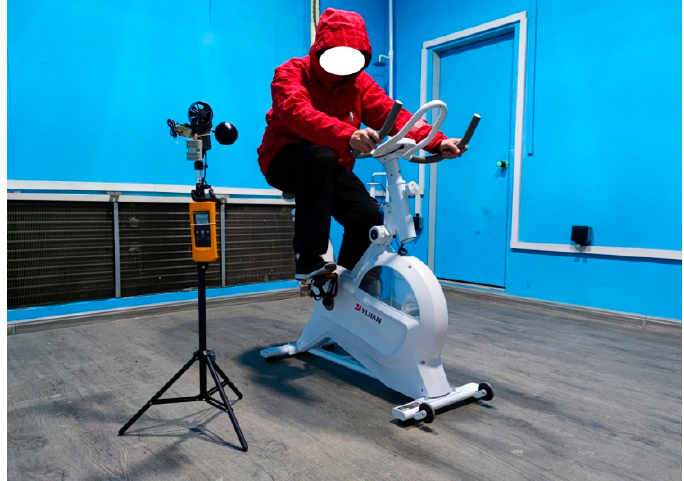
Figure 3. The experimental condition and scene.